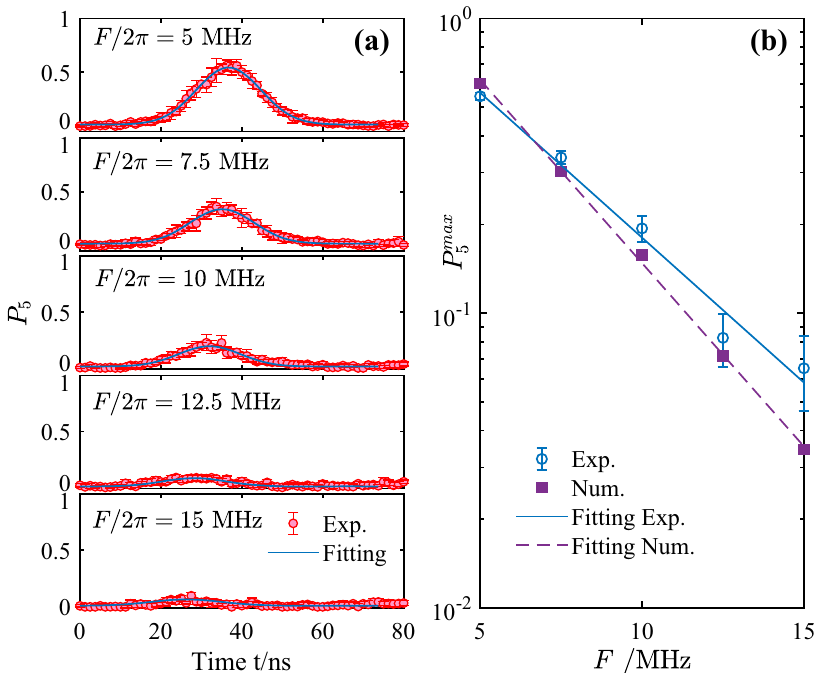
Fig. 3 Extracting WSL length. a The time evolution of photon occupancy probabilities at Q 5 for different potential gradients F . The initial state is 10000 j i . The red solid circles are experimental data points, and the blue lines are Gaussian fi ttings. The estimate method of errors is and F , where the experimental P max is the peak value of Gaussian curve shown in a . The presented in “ Methods ” . b The relation between P max 5 5 corresponding error bars are the fi tting errors. The numerical data points are peak values of the fi rst wavefronts of P 5 ( t ) without Gaussian fi tting 31 . Here, lnP max is nearly linearly related to the potential gradients F . The solid and dashed lines are the corresponding linear fi ttings of 5 the experimental and theoretic results,